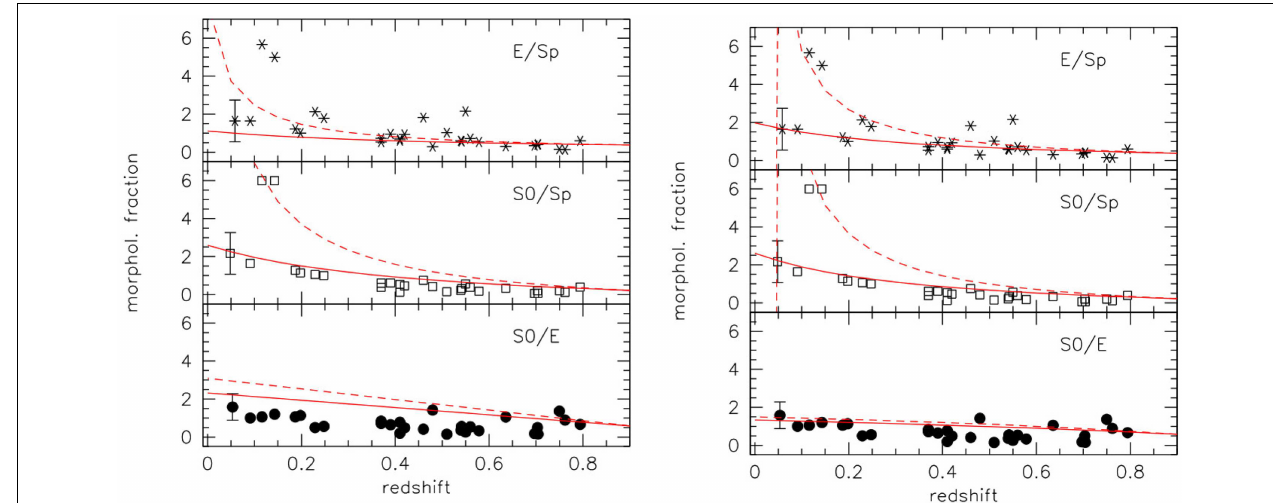
mark the trend obtained for a rate of transformation of 6.25 Sp S0’s per → Gyr and 0 Sp E’s per Gyr. The dashed lines instead are for a rate of 9 → Sp S0’s per Gyr and 0 Sp E’s per Gyr. Right: The same plot, but with the → → following transformation rates: 5 Sp S0’s per Gyr and 1.75 Sp E’s per Gyr → → for the solid lines, and 7 Sp S0’s per Gyr and 1 Sp E’s per Gyr for the → → dashed lines.